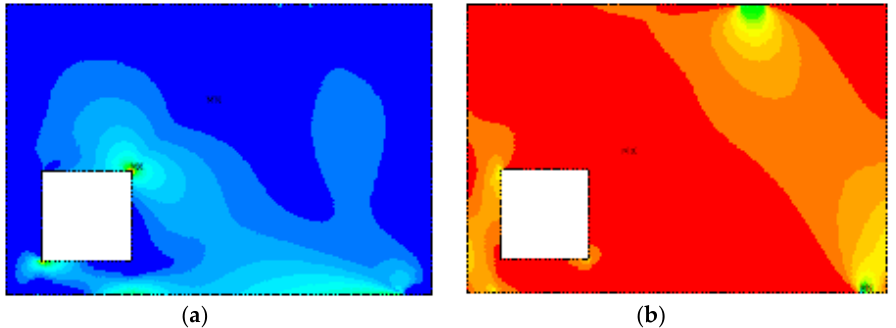
Figure 3. FE analysis results of the Group B irregular concrete deep beams: ( a ) Principal tensile stress ( b ) Principal compressive stress.